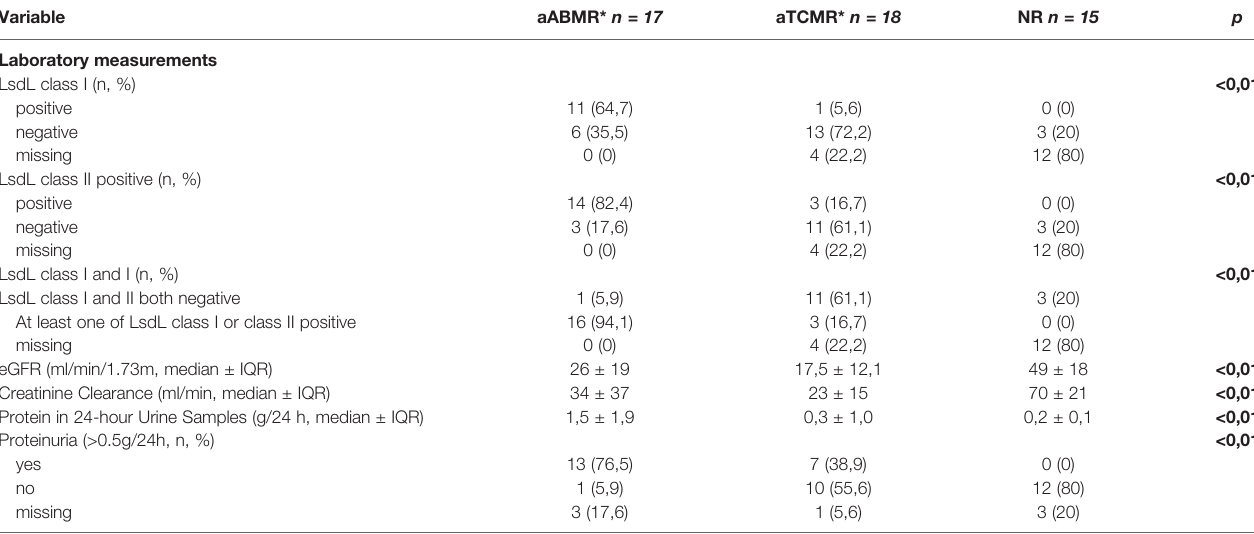
Categorical and dichotomous variables are presented as absolute numbers and respective percentages. Continuous, non-parametric variables are presented as median and with interquartilerange.Continuous,parametricdataisprovidedas meanandstandarddeviation.Categorical data,aswellas parametriccontinuousvariables,arecomparedbetweengroups by ANOVA, continuous non-parametric by Kruskal-Wallis test. Statistical signi fi cance is de fi ned as P < 0.05 (bold). aABMR, active antibody-mediated rejection; aTCMR, acute T-cell mediated rejection; NR, non-rejection; yrs, years; aHUS, atypical hemolytic syndrome; MPO, Myeloperoxidase; IQR, interquartile range; HLA, human leukocyte antigen; CMV, Cytomegalovirus; SV40, simian virus 40; IFTA, Interstitial Fibrosis and Tubular Atrophy; n.a., not applicable; LsdL, Life screen de Luxe; LSA, Lifecodes Single Antigen; DSA, donor- speci fi c antibodies; eGFR, Estimated Glomerular Filtration Rate. *According to Banff ’